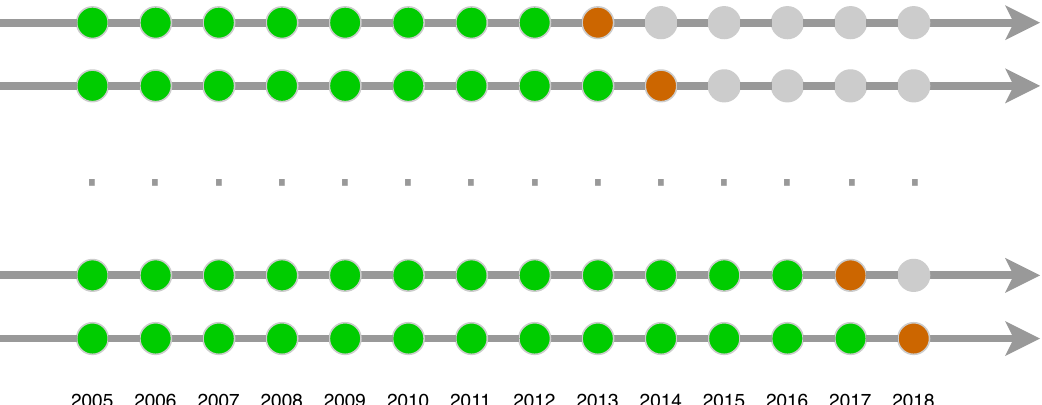
Figure 3. Expanding windows diagram. Note: The figure shows the composition of the learning (green circles) and testing (brown circles)